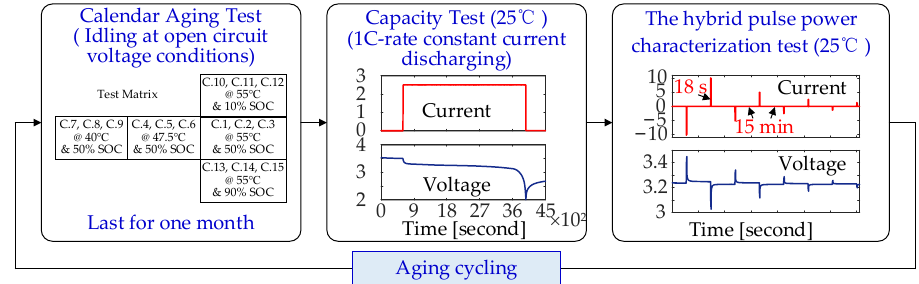
Figure 2. Flowchart of the calendar aging and reference tests procedure.